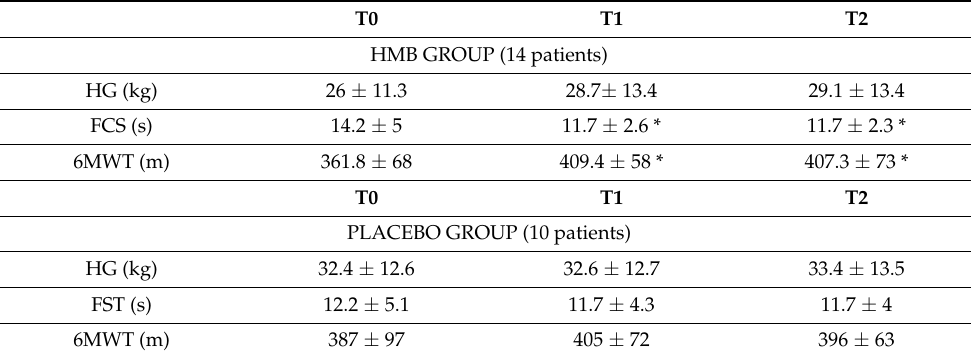
Table 4. Changes in muscle performance across the study. T0 T1 T2 HMB GROUP (14